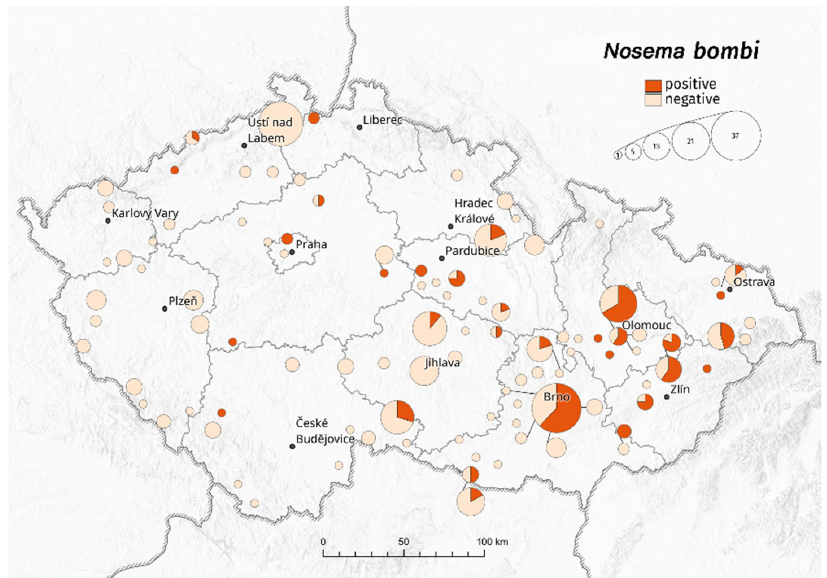
Figure 3. Sampling locations and the ratio of Nosema bombi infection to uninfected bumblebees in the Czech Republic. The circles reflect the number of samples in sampling locations. Table 1. Results of laboratory test, obtained by PCR detection for species B. terrestris/lucorum for pathogens C. bombi , A. bombi and N. bombi . W workers, M males, * low number of samples—not evaluated.